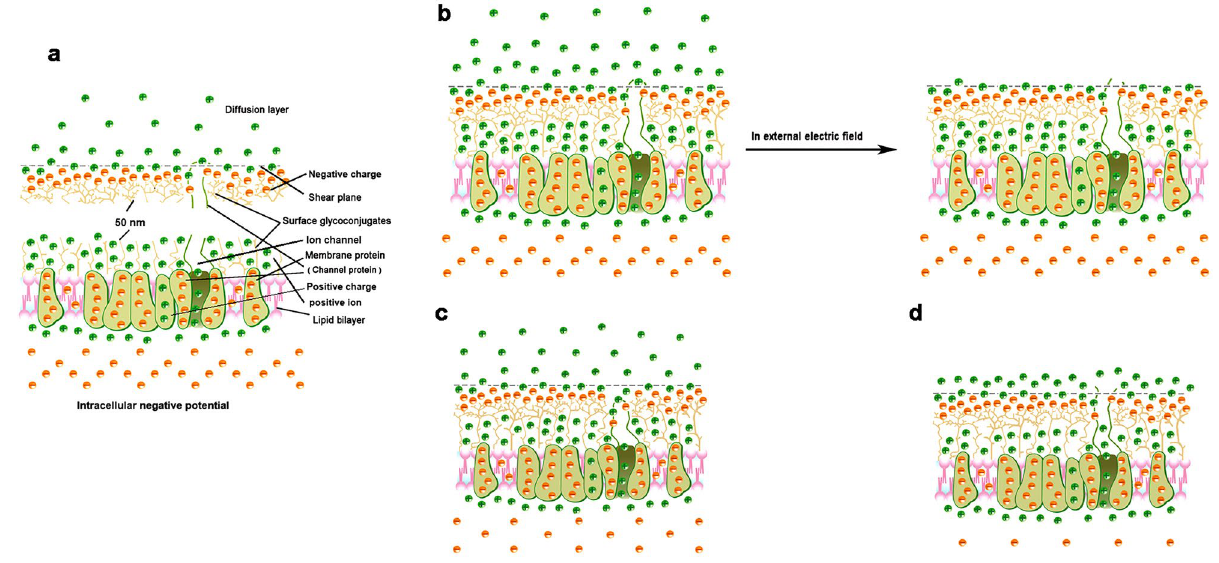
Figure 5. Influence of potential effect on the ion adsorption structure of the cardiomyocytes surface. Schematic diagrams of the surface structure of cardiomyocytes ( a ). Under physiological conditions, when an external electric field is applied (or in a negative electric field), the surface structure of the cardiomyocytes membrane changes ( b ); the K + channel (outward) of cardiomyocytes is similar to it. When the transmembrane potential changes (within a certain range), the surface electric double layer on the cell membrane changes (thickness and diffusion layer), and cardiomyocytes can show three behaviors: contraction ( b ), or non-contraction ( c ), or autorhythmicity ( d